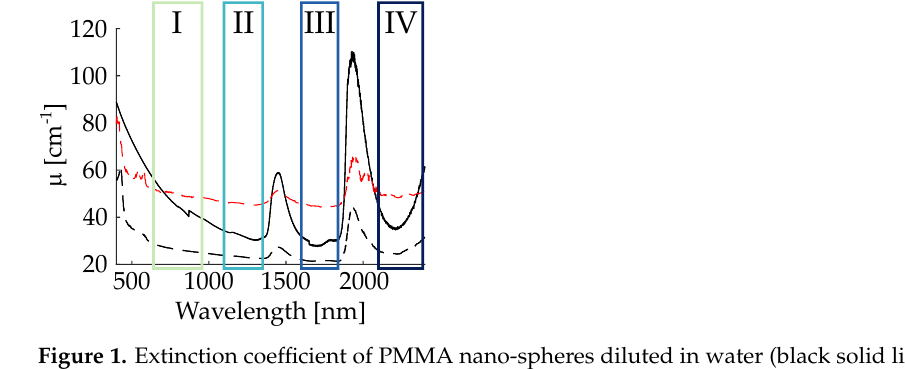
Figure 1. Extinction coefficient of PMMA nano-spheres diluted in water (black solid line) used as phantom tissue, skin (black dotted line) and skull bone (red dotted line). Superposed to the spectra, the information on the biological windows NIR-I, II, III, IV are added. (Spectra of skin and skull bone are taken from Ref.